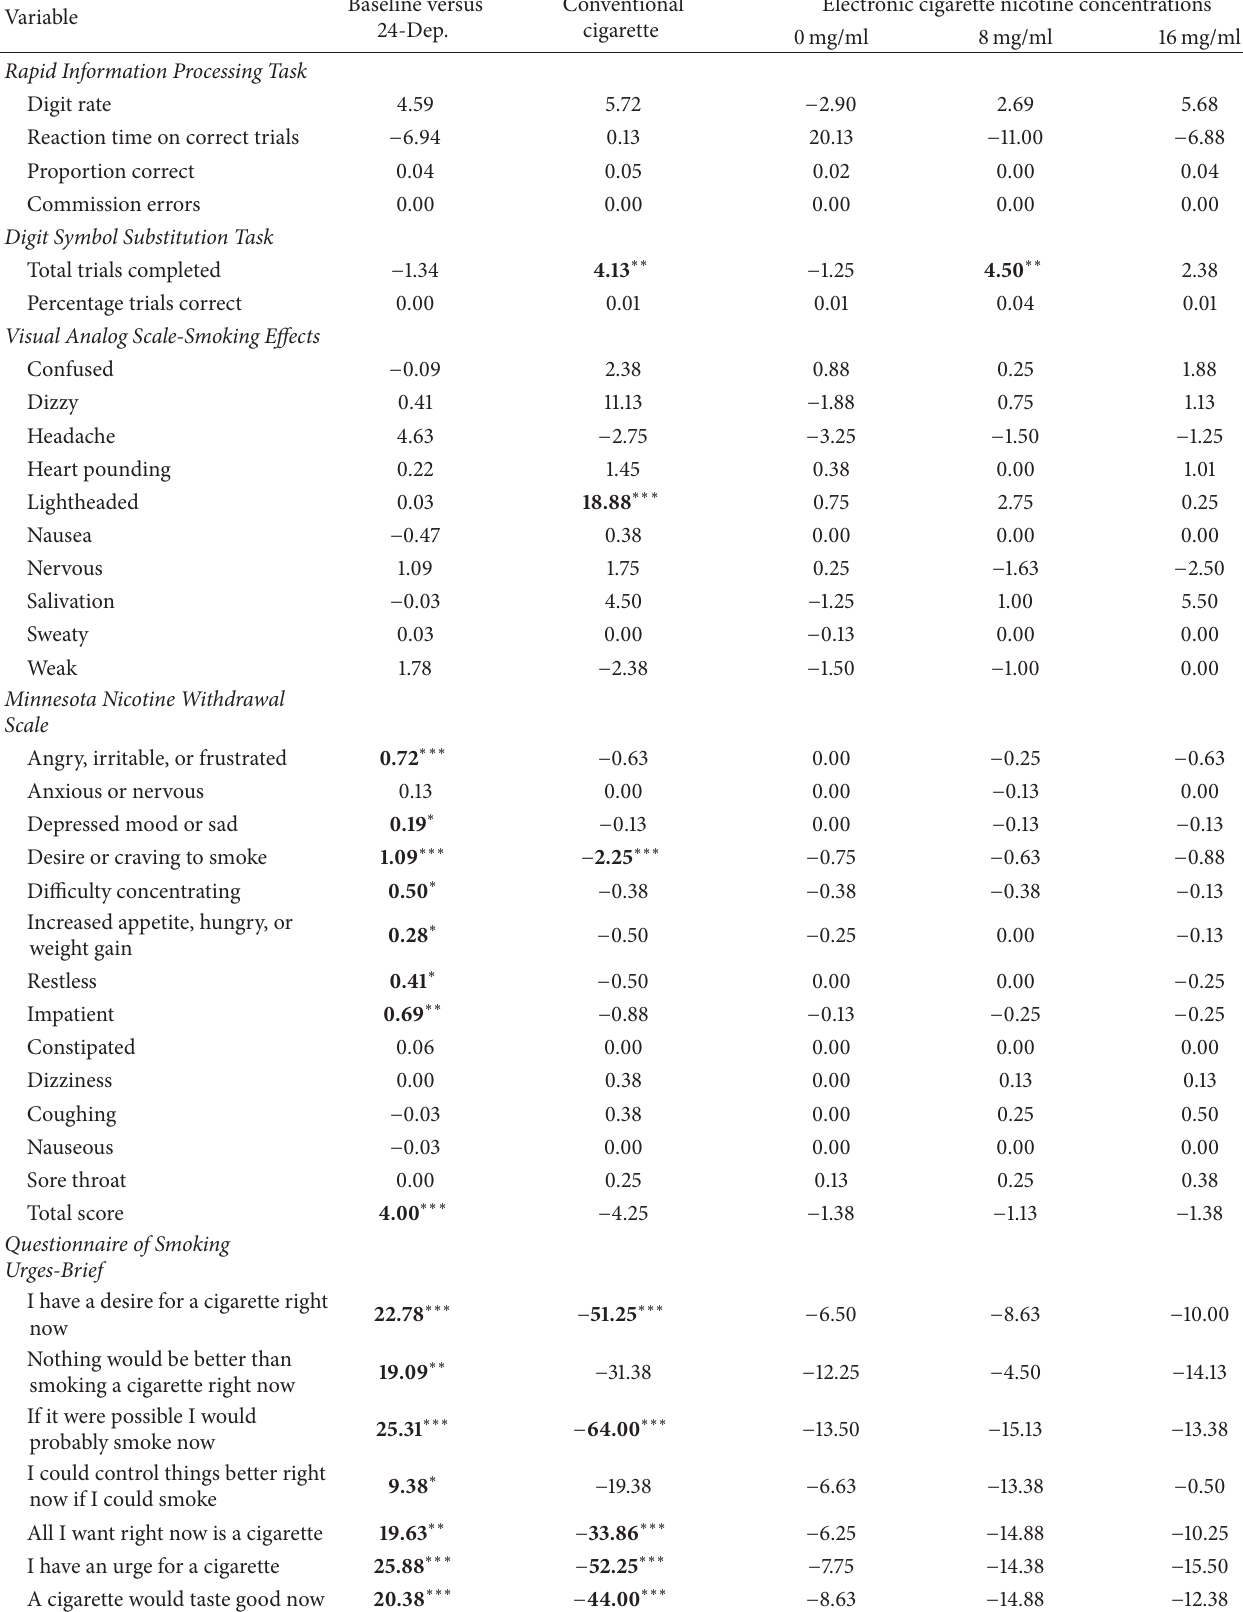
Table 1: Least-square mean changes in subjective, cognitive, and physiological effects by session and condition.